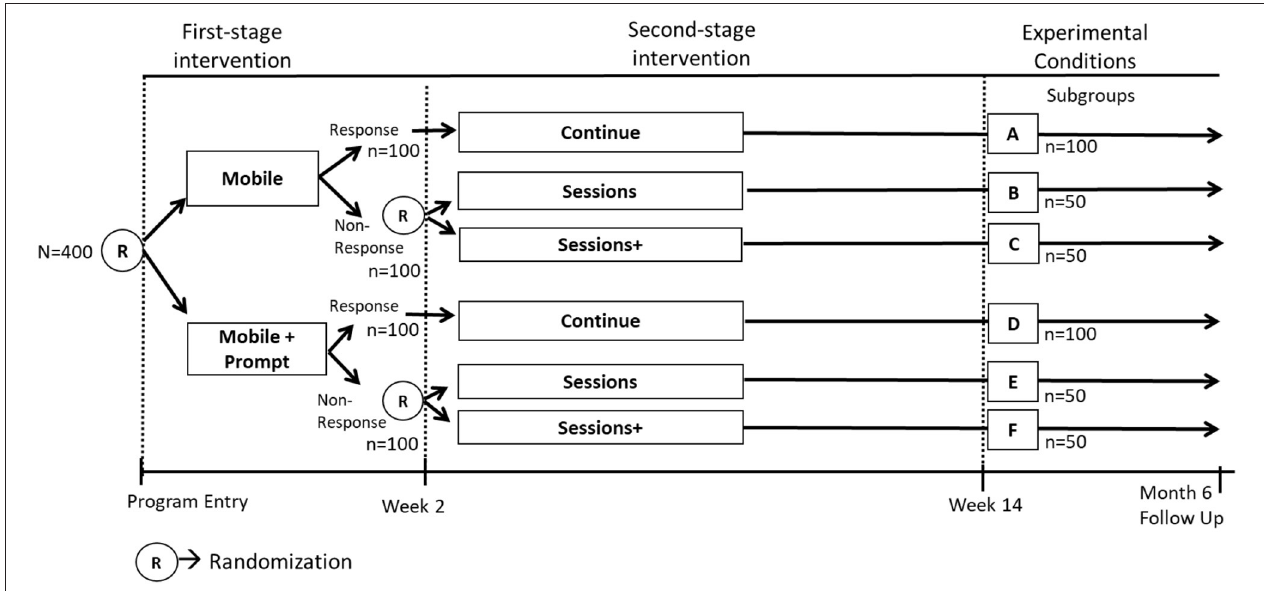
FIGURE 3 | SMART study to answer example C scientific